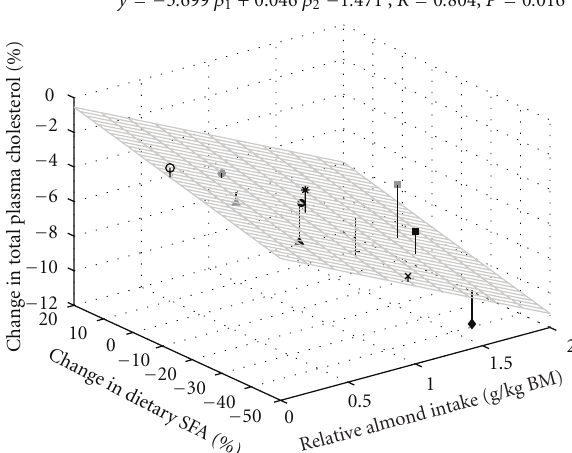
Figure 2: Multiple regression analysis of independent variables (mean relative almond intake and percent change in mean dietary saturated fatty acid) and percent change in mean plasma total cholesterol. Correlation was considered significant at P < 0 . 05. See Figure 1 legend for symbol identification.